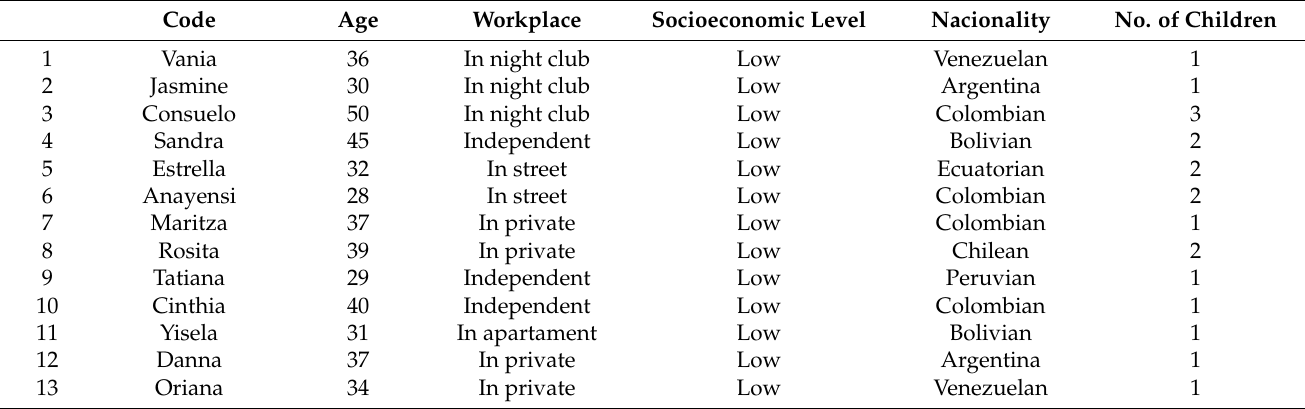
Table 1. Participants in the